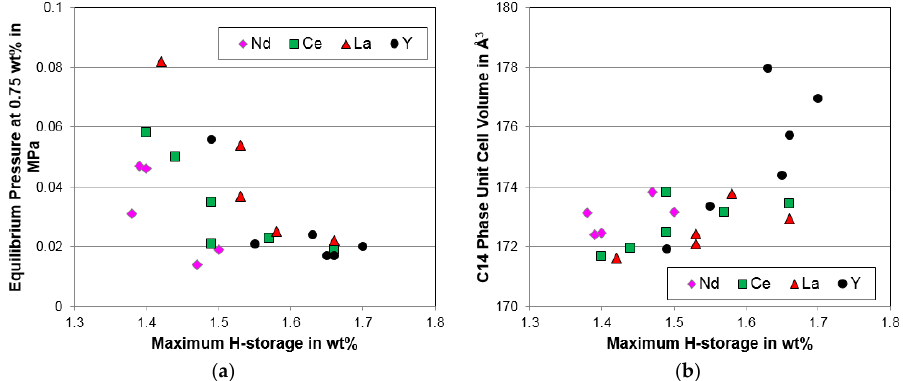
Figure 8. Correlations between the maximum H-storage and ( a ) equilibrium pressure at 0.75 wt% H- storage; and ( b ) C14 phase unit cell volume.